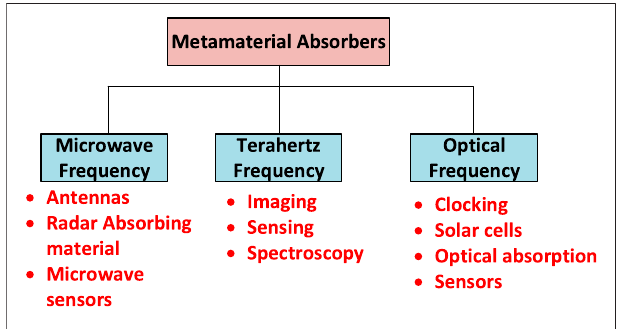
FIGURE 3 | Applications of metamaterial absorber with respect to different